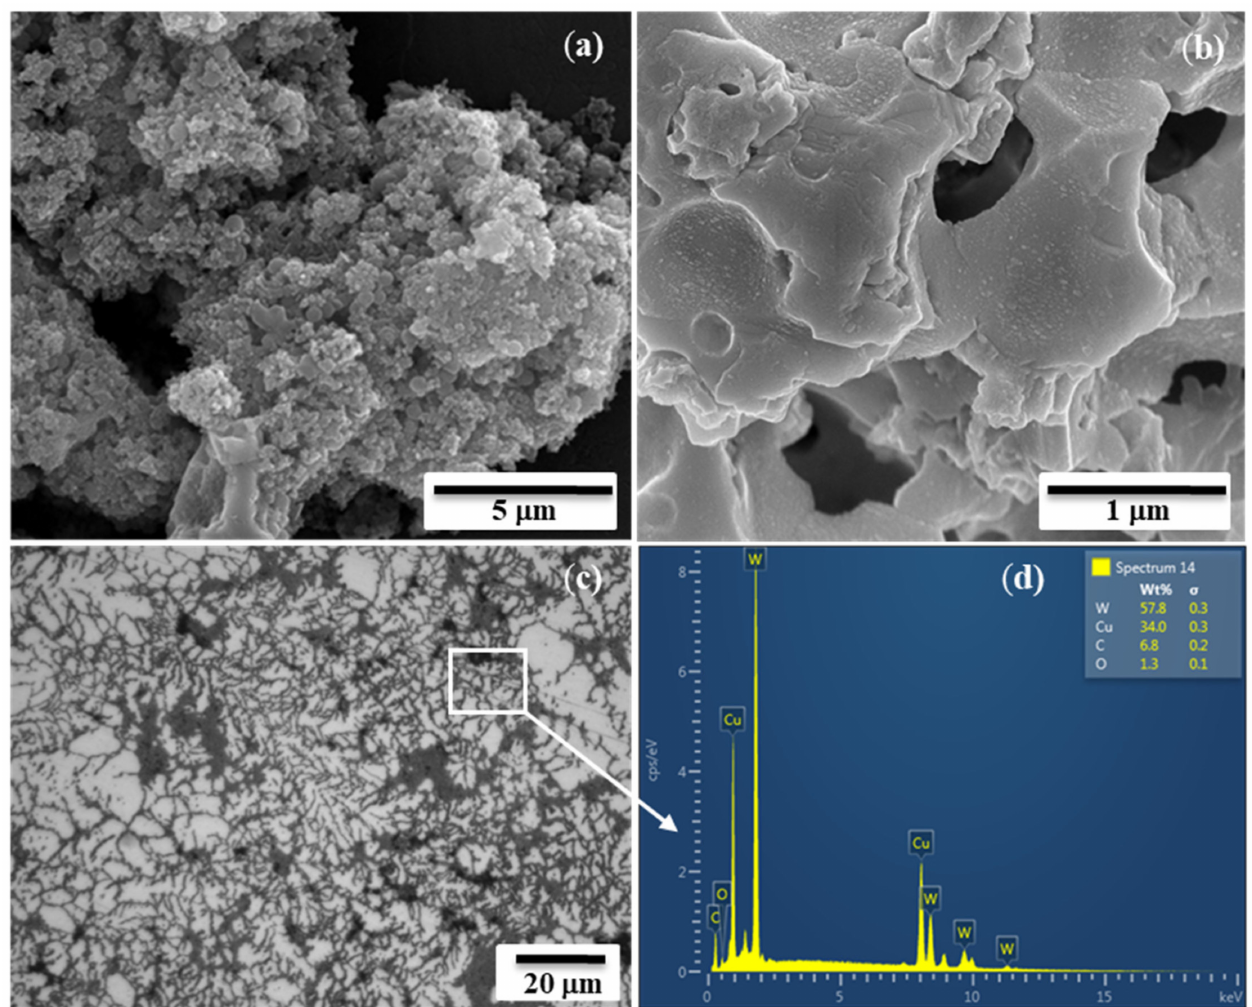
Figure 4. SEM images of SHS-derived W-Cu powder ( a , b ) and SEM/EDS of fracture surface of HEC counterparts ( c , d ).